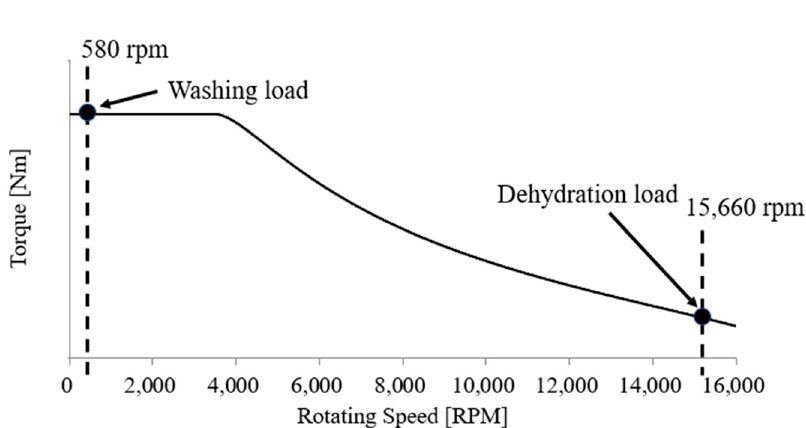
Figure 2. Operating point of washing load and dehydration load of the conventional model. Table 1. Specifications of conventional model.